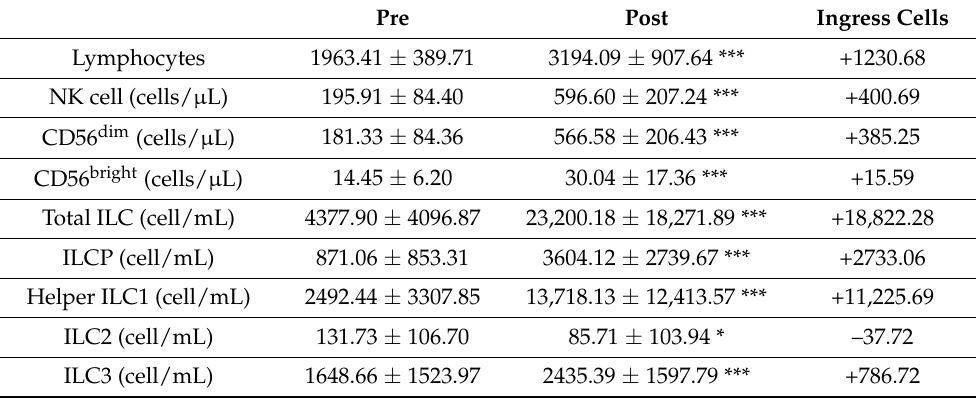
Table 3. Total number of peripheral blood lymphocytes, NK cells (cells/ µ L), and ILCs (cells/mL) in response to acute exercise ( n = 22).